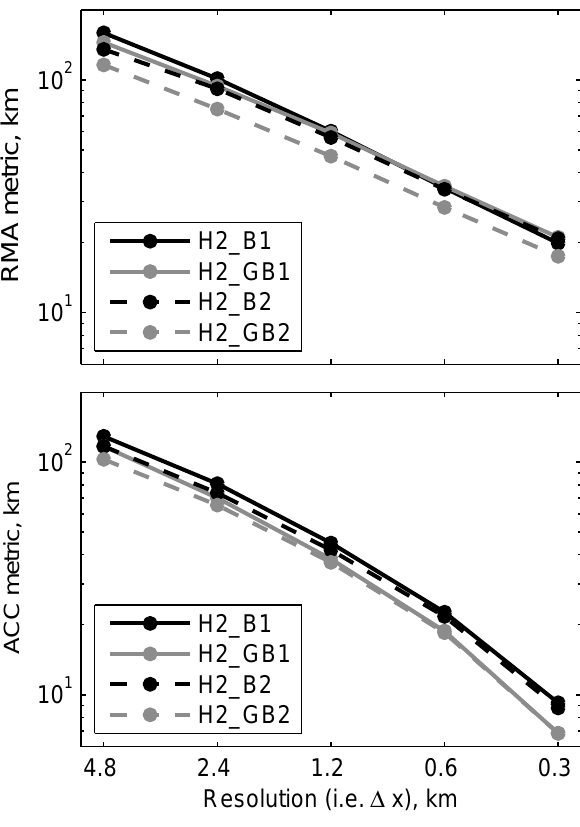
Fig. 9. Error metrics ACC and RMA (Sect. 4.1) plotted against resolution for the GLPs using the 2nd order harmonic mean based thickness profile (H2, Sect. 3.1.6). Results are shown for all forcing term corrections (see Table